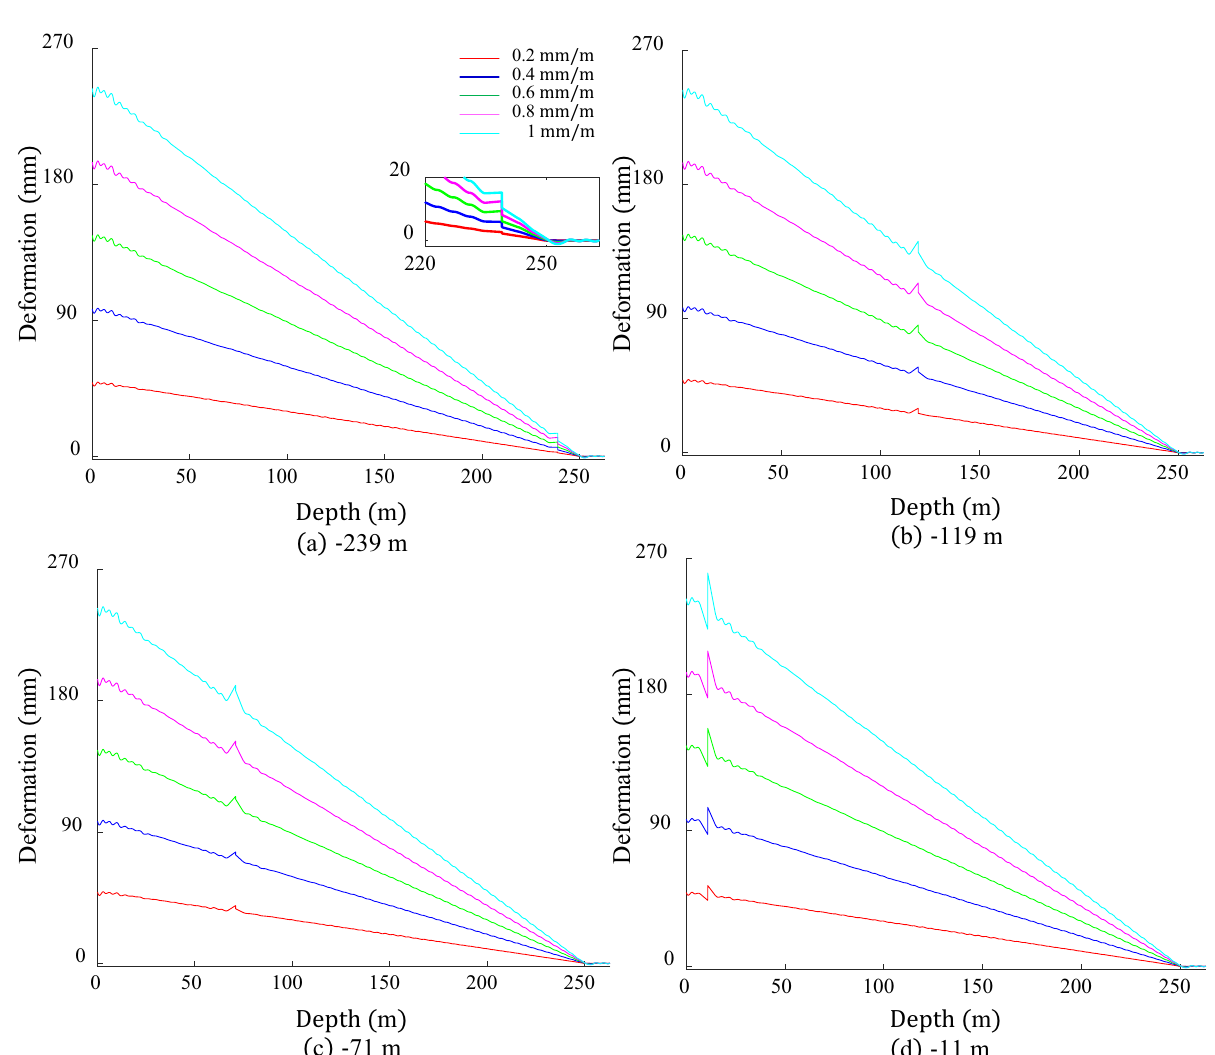
Figure 10. GRD in x -direction under inclination when bunton is disconnected from